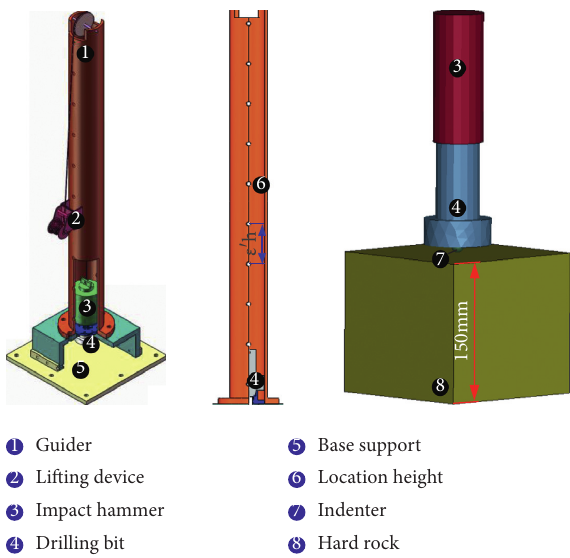
Figure 1: Test device for rock breakage by indenter impact. Table 1: Parameters of the experimental device.